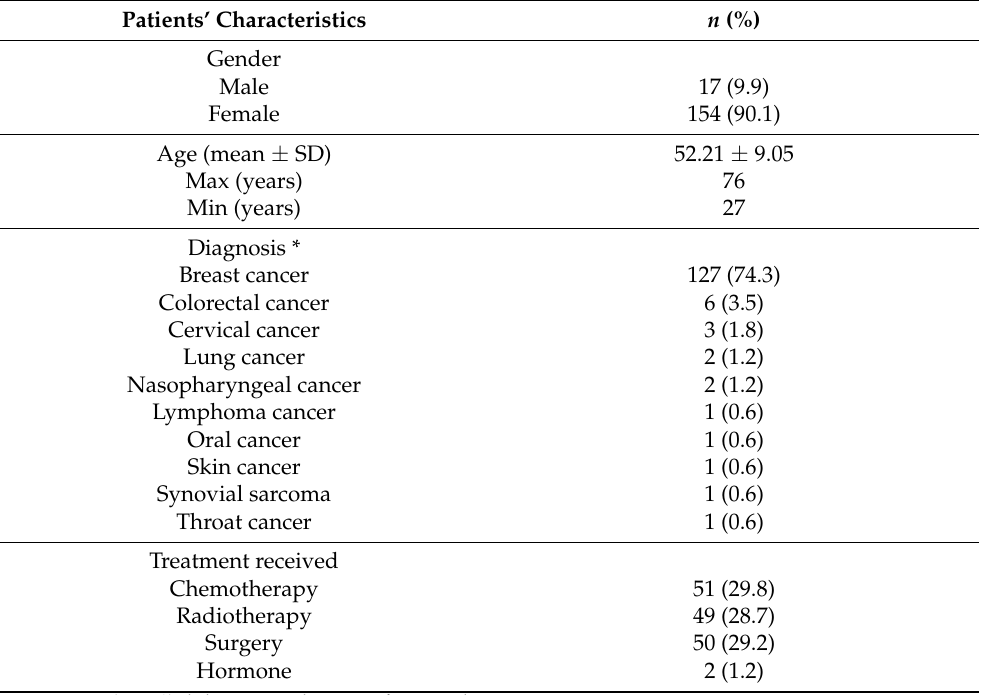
Table 1. Characteristics of the participants ( n =